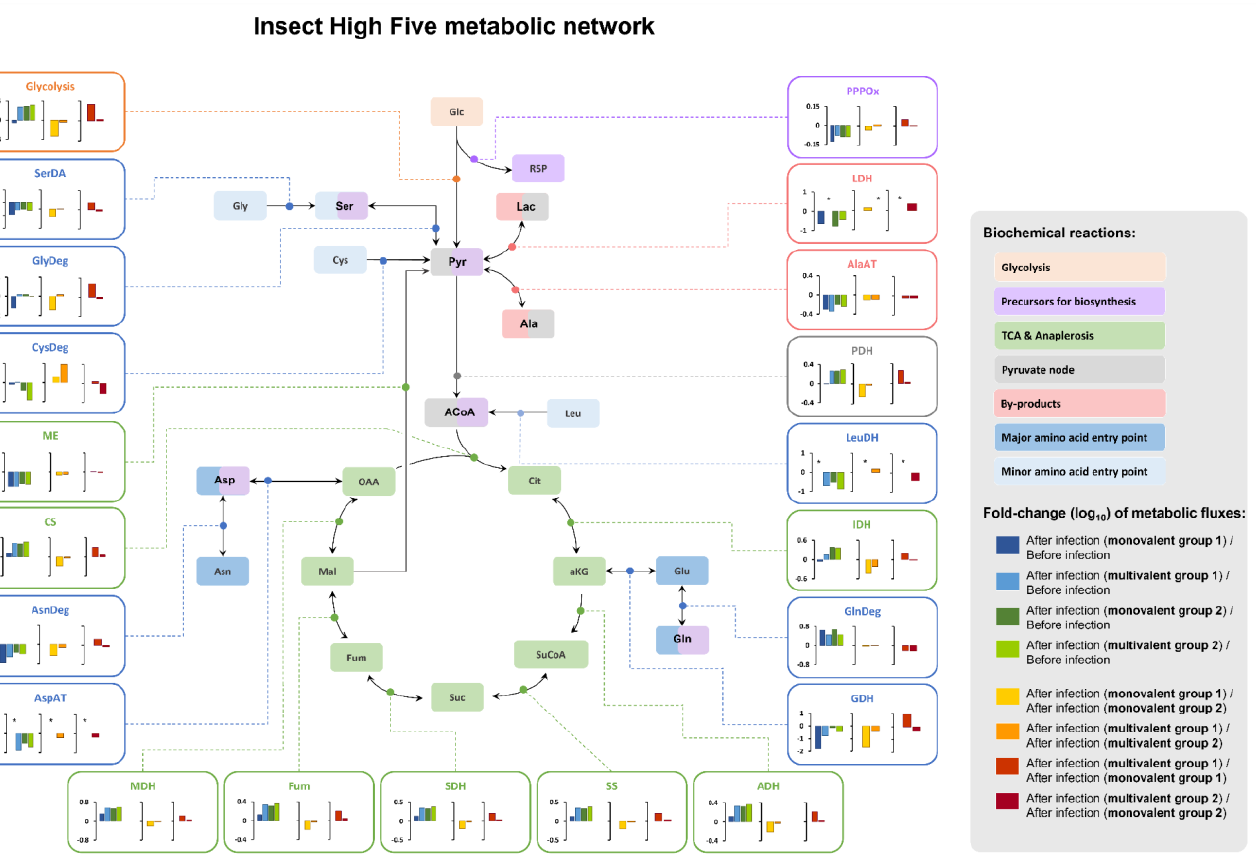
Figure 3. Insect High Five cells metabolic network. Acronyms: α KG—alpha-ketoglutarate; α KGDH—alpha-ketoglutarate dehydrogenase; ACoA — acetyl-CoA;